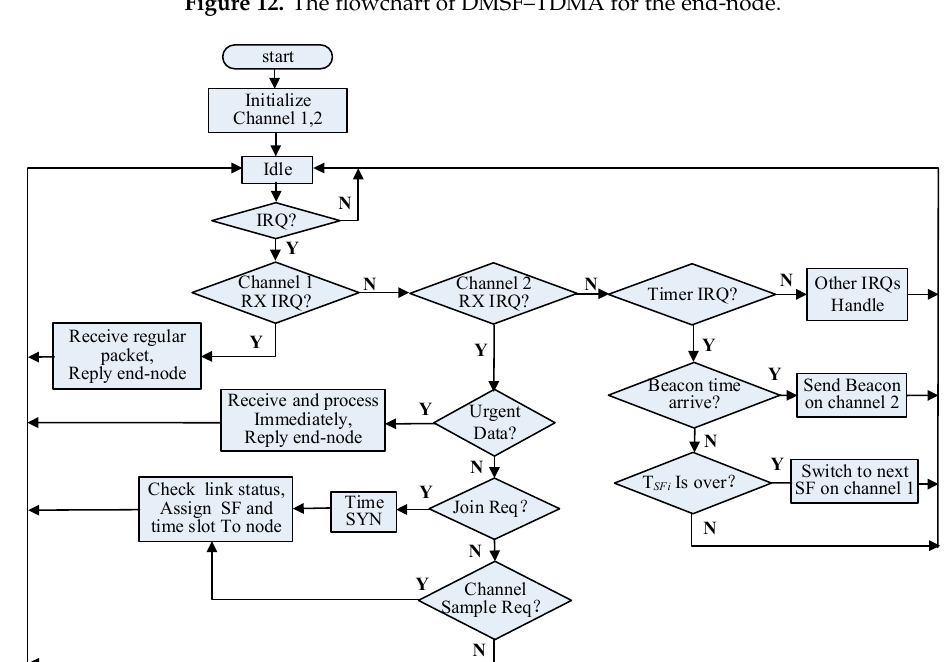
Figure 13. The flowchart of DMSF–TDMA for the gateway.